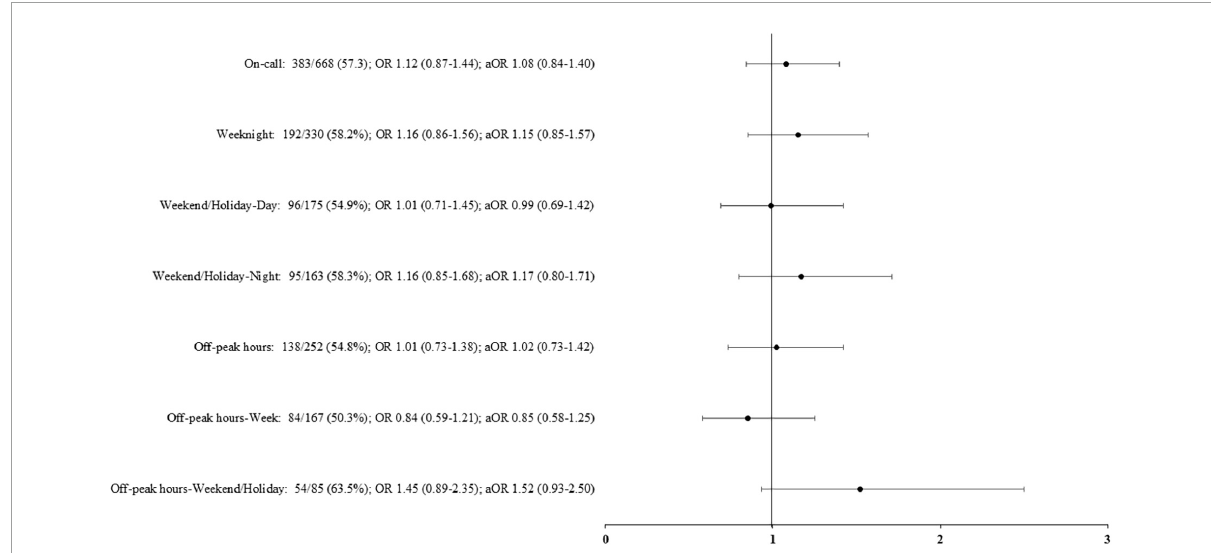
FIGURE1 Survival without severe morbidity according to the period of birth. Adjusted odds ratio (aOR), weighted by the propensity score, and their 95% confidence interval shown of the figure, are expressed vs. weekday. On-call: defined as birth in weekdays between 6.30 p.m. and 8.30 a.m., in weekends and public holidays. Off-peak hours: defined as birth between 12:00 a.m. and 6:59 a.m.